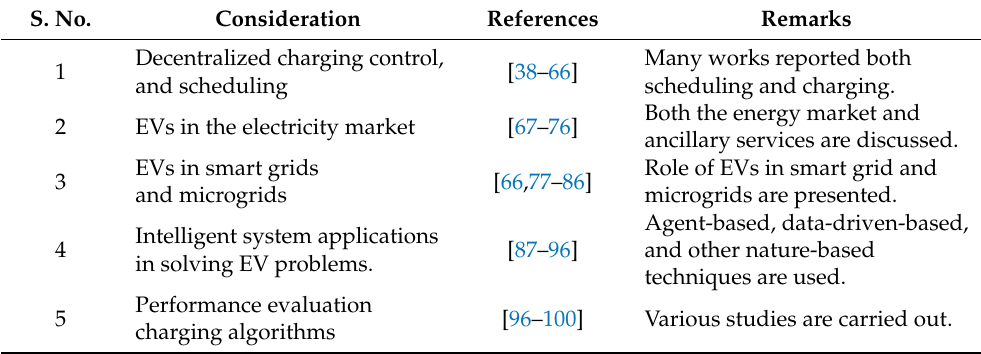
Table 1. Summary of various EV charging, scheduling, and control strategies. S.